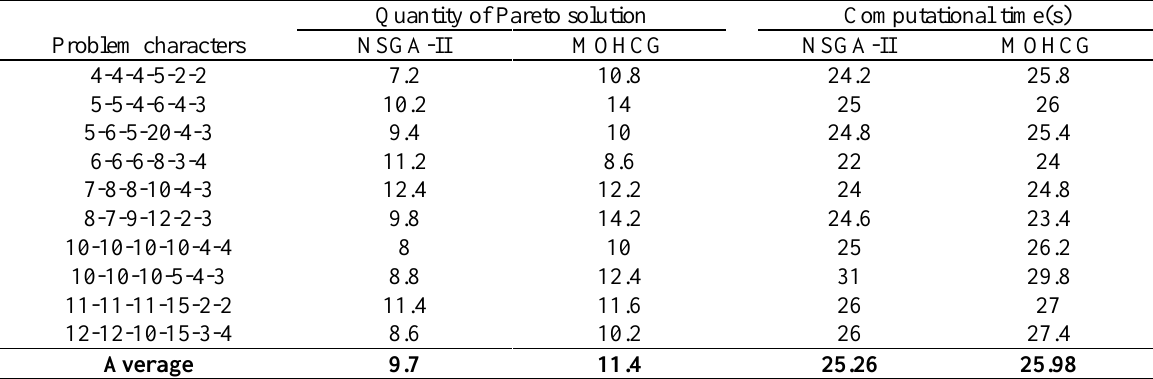
Table 2 . Quantity of Pareto solutions and computational time for medium/large-sized problems Quantity of Pareto solution Computational time (s) Problem characters NSGA-II